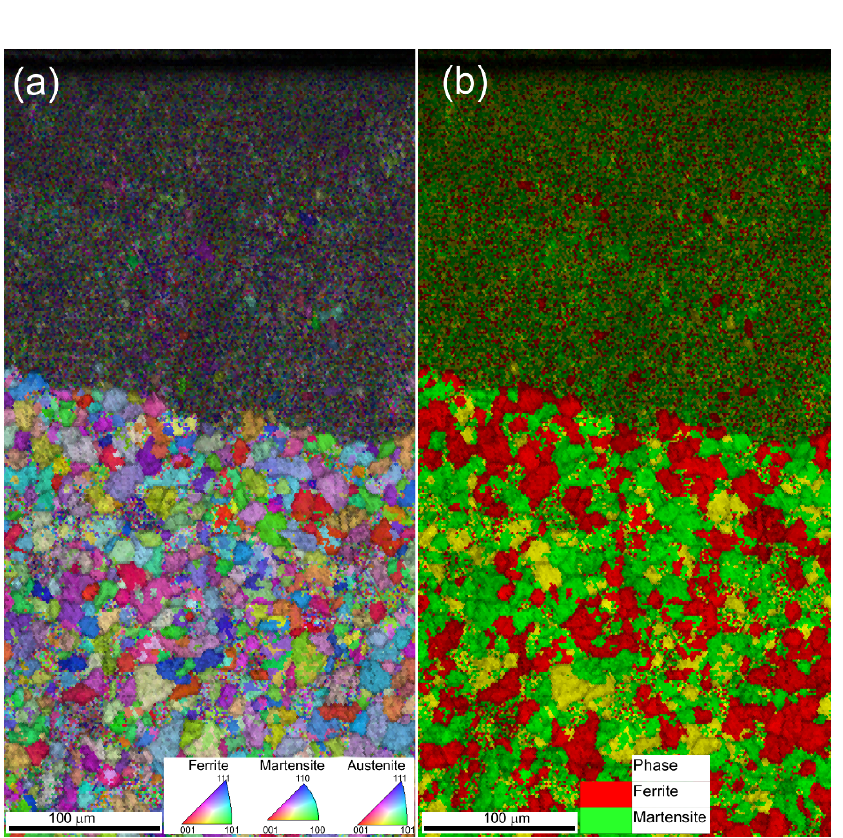
Figure 14. EBSD maps of a disk made of X38CrMoV5-1 tool steel without electro-machined surface for ( a ) raw material and ( b ) after LP treatment.